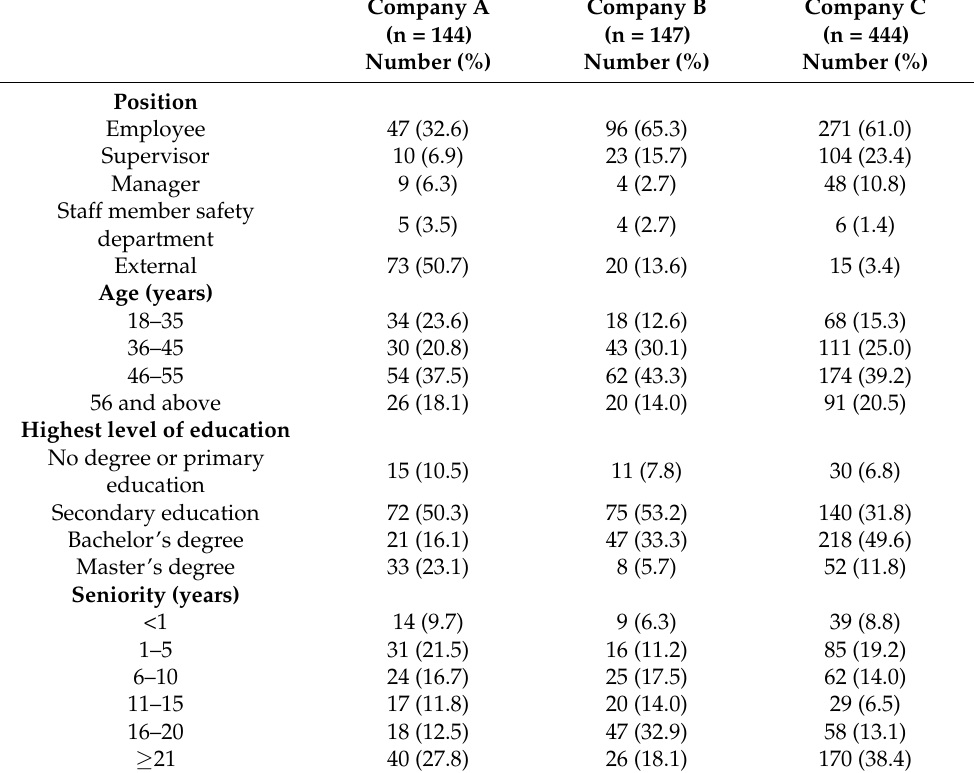
Table 1. Descriptive characteristics of the study